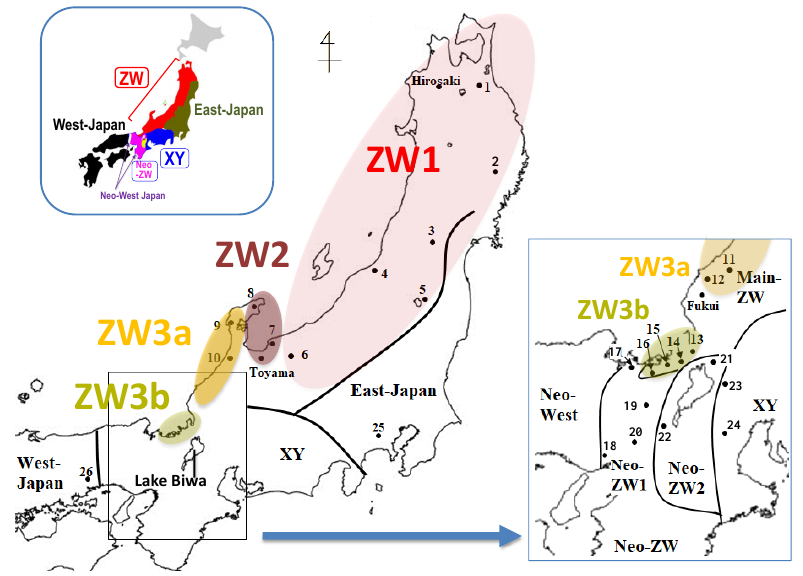
Figure 1. Map showing locations of 26 populations in Glandirana rugosa used in this study. The populations of ZW group are divided into three sub-groups closed in colored circles. Dots with numbers indicate 26 populations used in this study and three cities (with names of Hirosaki, Toyama and Fukui, shown in the study of Miura et al. [16]). The major six geographic groups are shown at top left and magnification of the central Japan area is shown at bottom